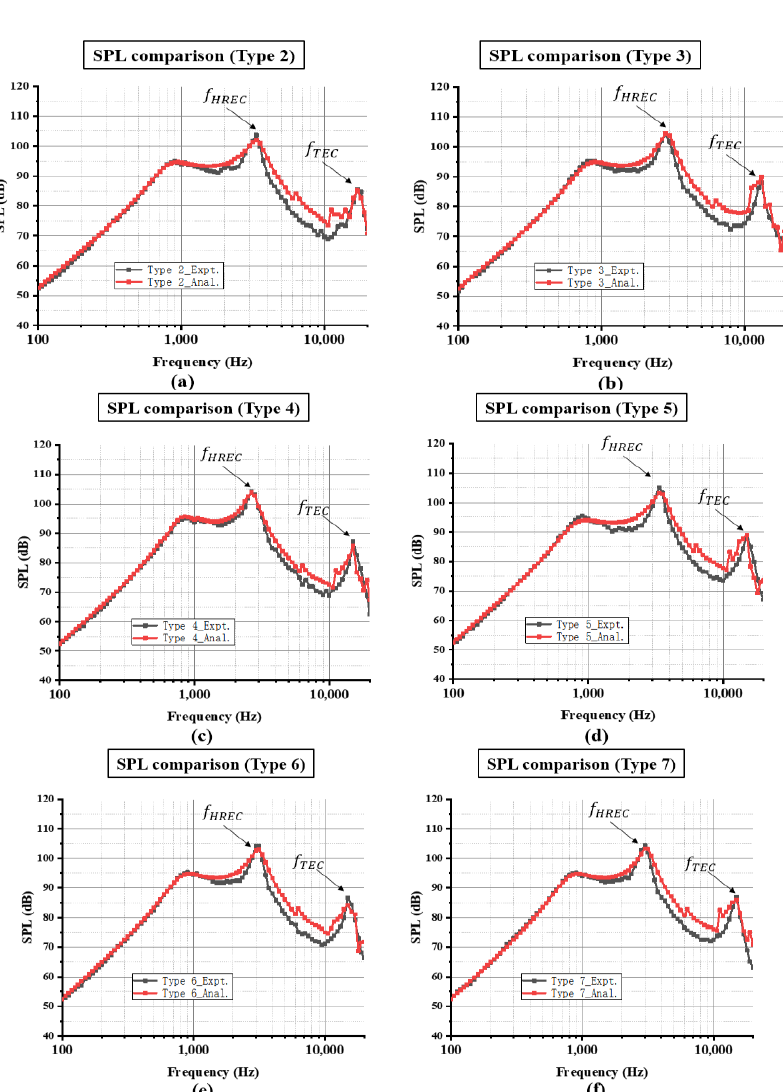
Figure 12. SPL Comparison between experimental and analysis results. ( a ) Type 2, ( b ) Type 3, ( c ) Type 4, ( d ) Type 5, ( e ) Type 6, ( f ) Type 7.